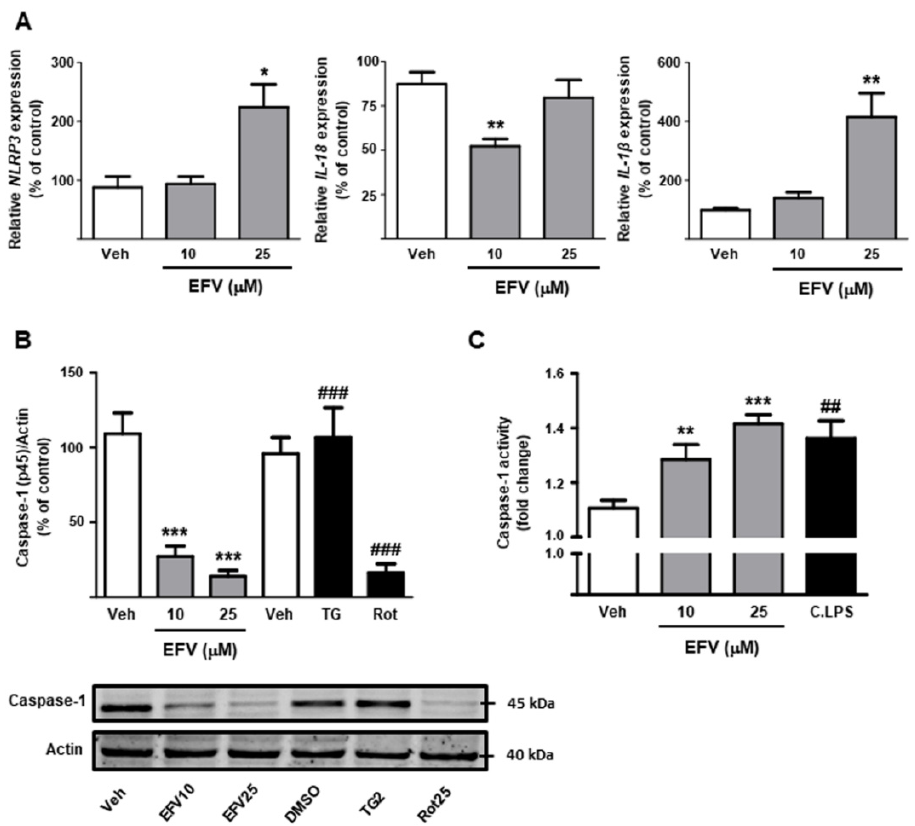
Figure 2. Efavirenz activates NLRP3 inflammasome components in Hep3B cells. ( A ) Determination of relative mRNA expression levels of genes associated with the NLRP3 inflammasome ( NLRP3 , IL-18 and IL-1 β ) by RT-PCR. Data were normalized versus the housekeeping gene β -actin (n = 5–6). ( B ) Representative Western Blot image of the inactive form of Caspase-1 (45 kDa) and summary of densitometry data after 24 h treatment (n = 5). ( C ) Analysis of Caspase-1 activity using a colorimetric assay. All data (represented as mean ± SEM, n = 5–6) were calculated as a percentage of control (untreated cells) and analyzed by one-way ANOVA multiple comparison test followed by a Newman–Keuls test (* p < 0.05, ** p < 0.01, *** p < 0.001 versus the respective solvent). Thapsigargin (TG), rotenone (Rot) and cocktail of LPS (C.LPS) were independently analyzed by a Student’s t -test ( ## p < 0.01, ### p < 0.001).